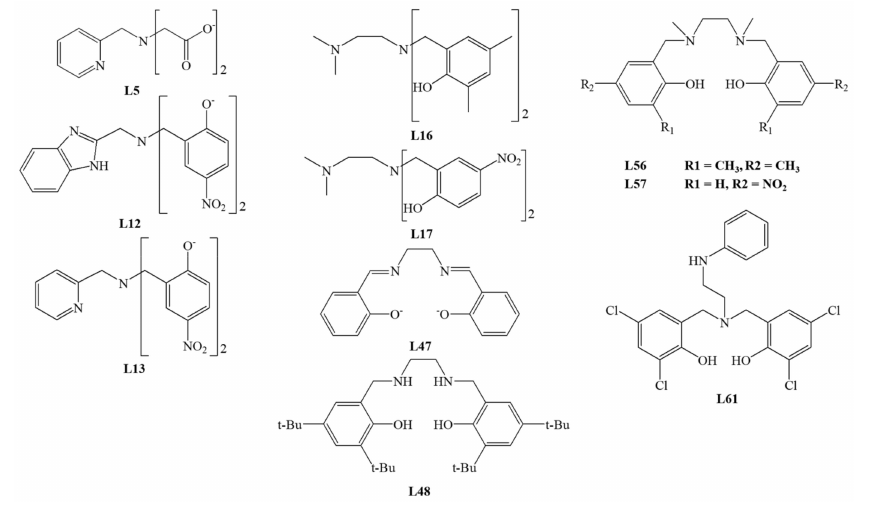
Figure 8. Tetradentate N 2 O 2 donor